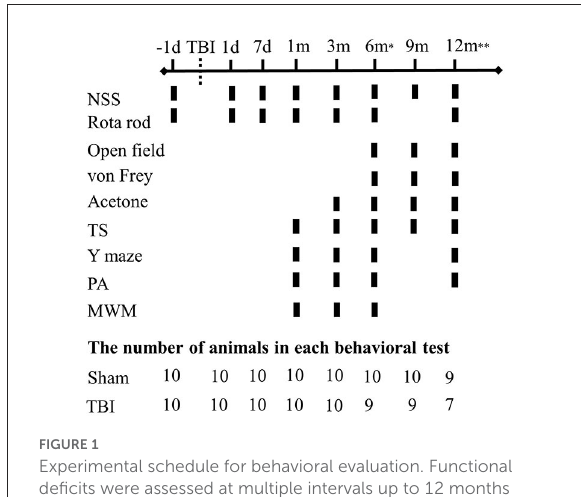
FIGURE1 Experimental schedule for behavioral evaluation. Functional deficits were assessed at multiple intervals up to 12 months post-injury ( n = 10/group). (d-days, m-months, NSS-neurological severity score, TS-tail suspension, PA-passive avoidance, MWM-Morris water maze). * One animal died in the TBI group. ** Two animals died in the TBI group and one animal died in the sham group.